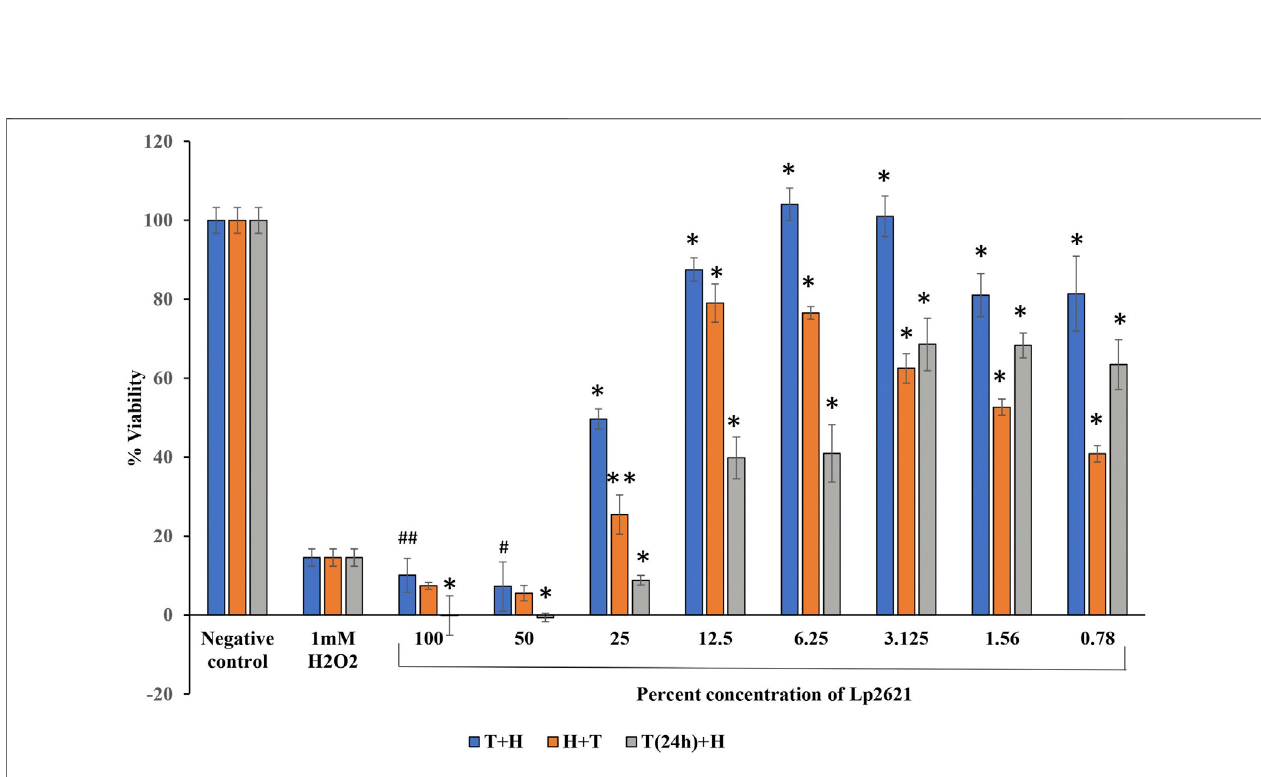
Frontiers in Pharmacology |